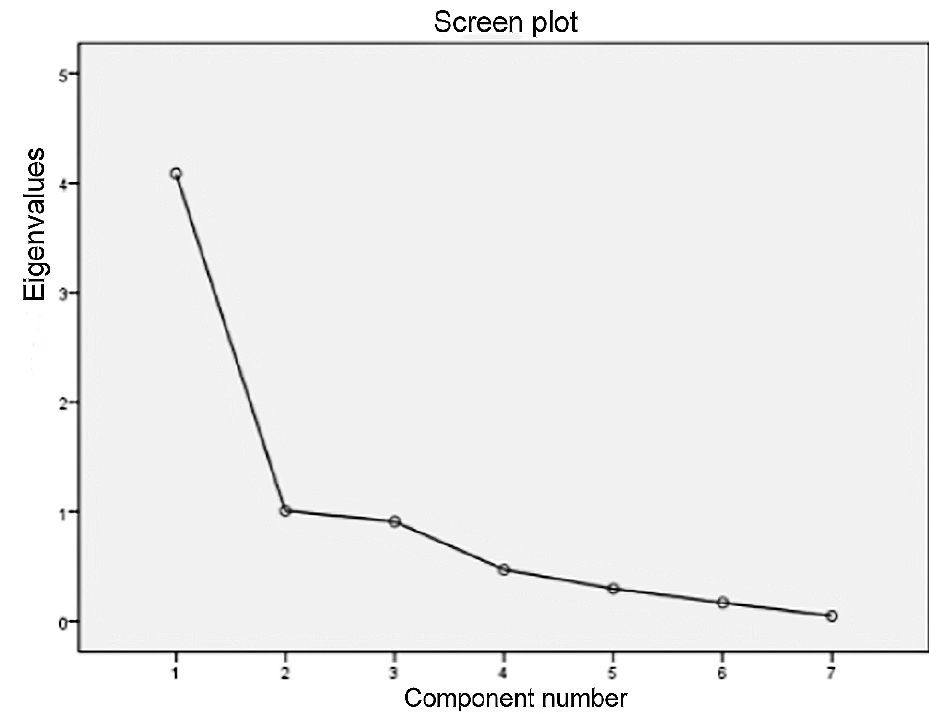
Figure 2. Scree plot.